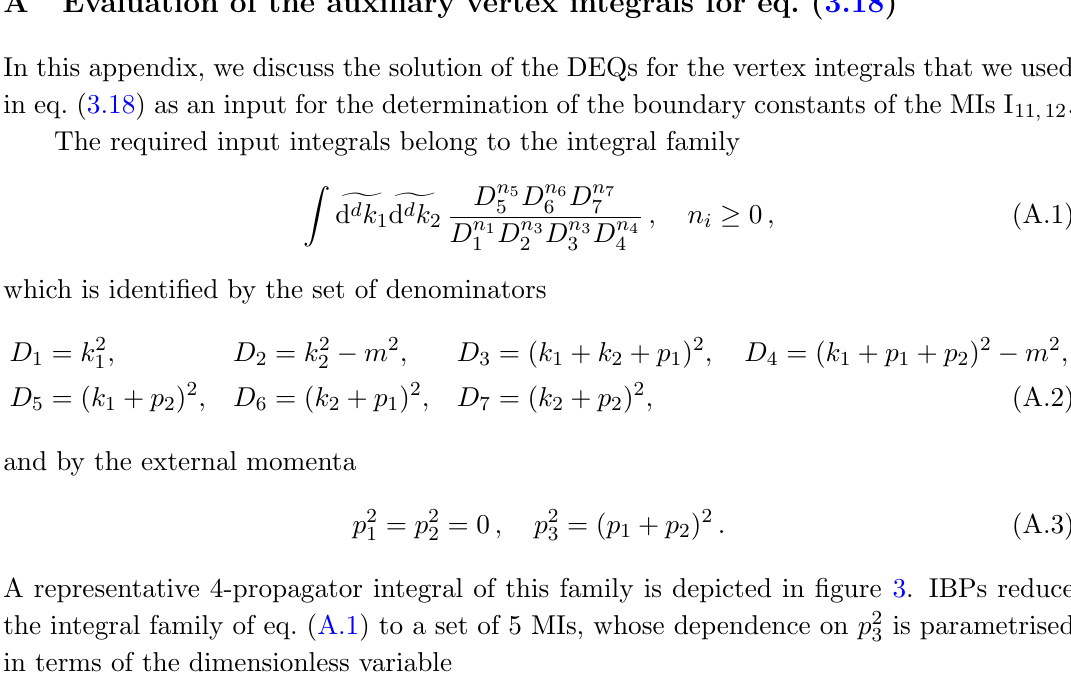
Figure 3. Auxiliary three-point integral family for eq. (3.18). Thick and thin lines represent, respectively, massive and massless propagators. The dashed line corresponds to an external leg with arbitrary squared